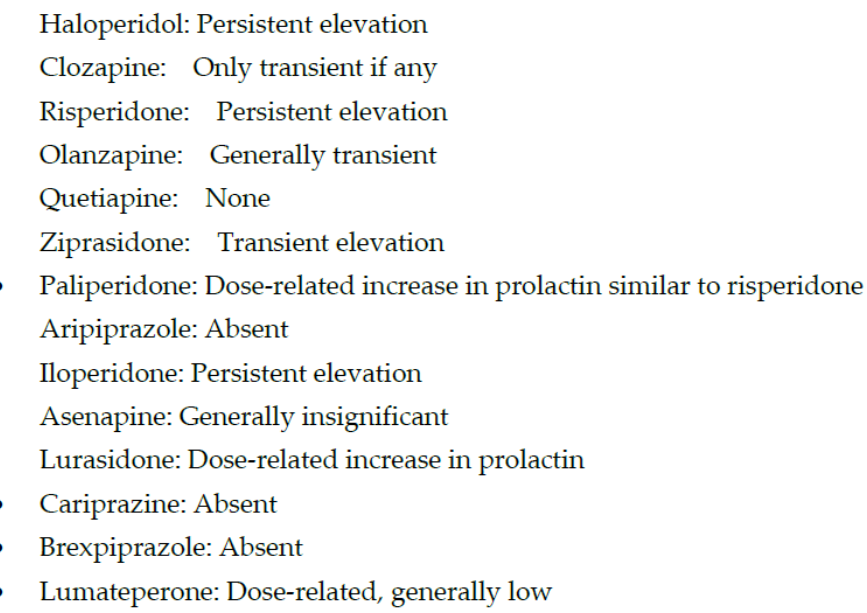
Figure 2. Hyperprolactinemia with antipsychotic medications.